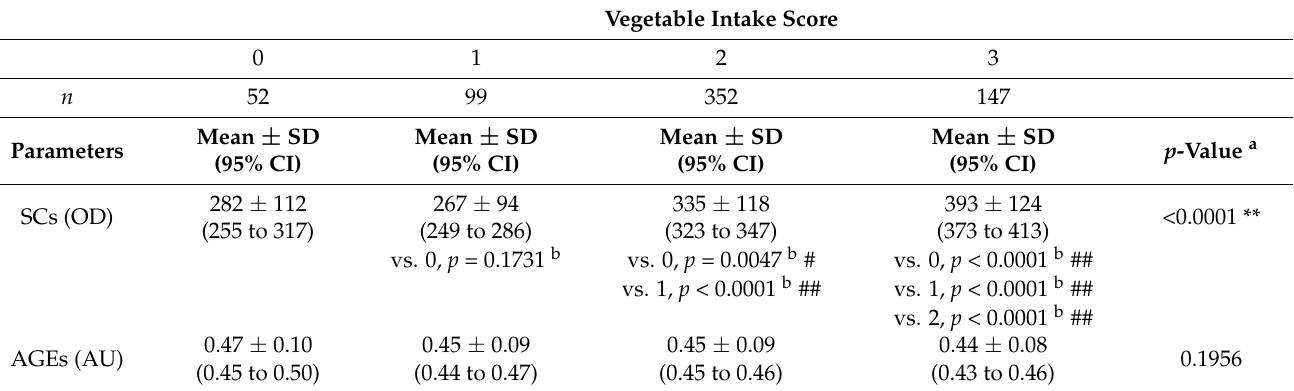
Table 6. Possible association between vegetable intake scores with SCs and AGEs. Vegetable Intake Score